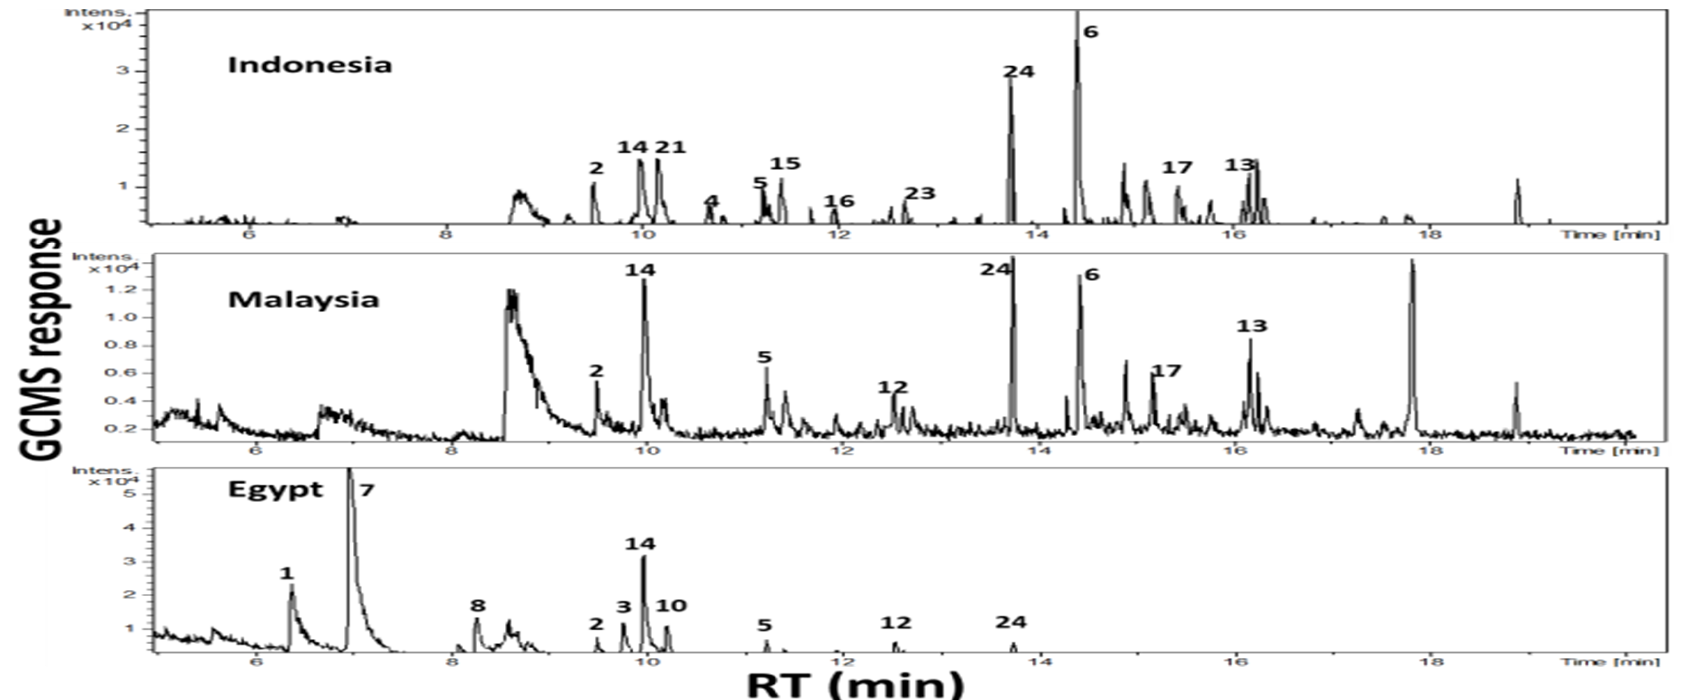
Figure 4. Headspace GC-MS total ion chromatograms (TIC) of volatile metabolites in ripe fruits grown in Indonesia, Malaysia and Egypt with peaks numbered followed that listed in Table 2.